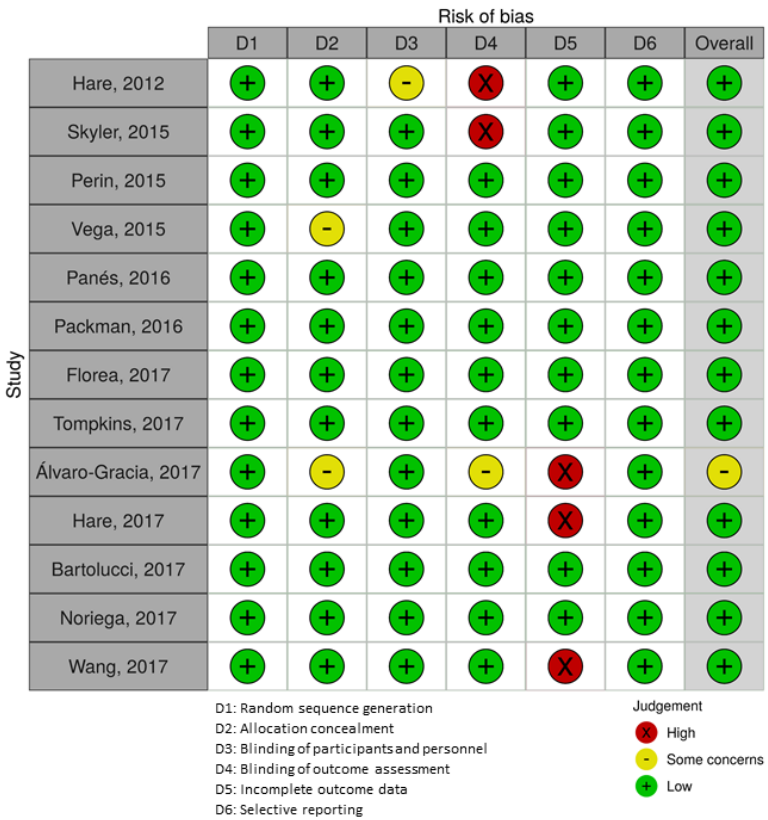
Figure 3. Quality assessment of the included studies. The risk-of-bias summary is based on the review authors’ judgements about each risk-of-bias item for each individual study: The green circle indicates low risk, and the red circle indicates high risk. Some concerns risk is represented by the yellow circle.